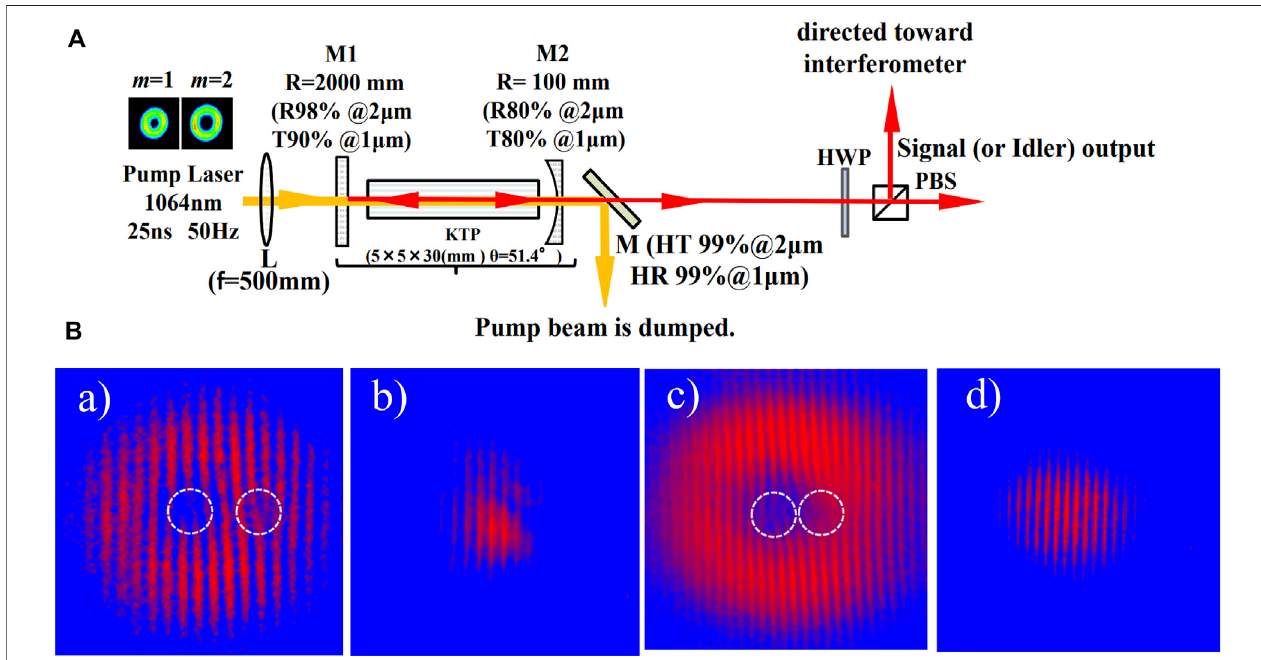
FIGURE10|(A) Con fi gurationsofa2- μ mtunableopticalparametricoscillatorwithvortexcharacteristicsbasedonaKTPcutalong θ =51.4 ° ; (B) a)~d)interference fringes of a) signal wave and b) idler wave obtained when pumped by the fi rst-order vortex beam; and c) signal wave and d) idler wave obtained when pumped by the second-order vortex beam.